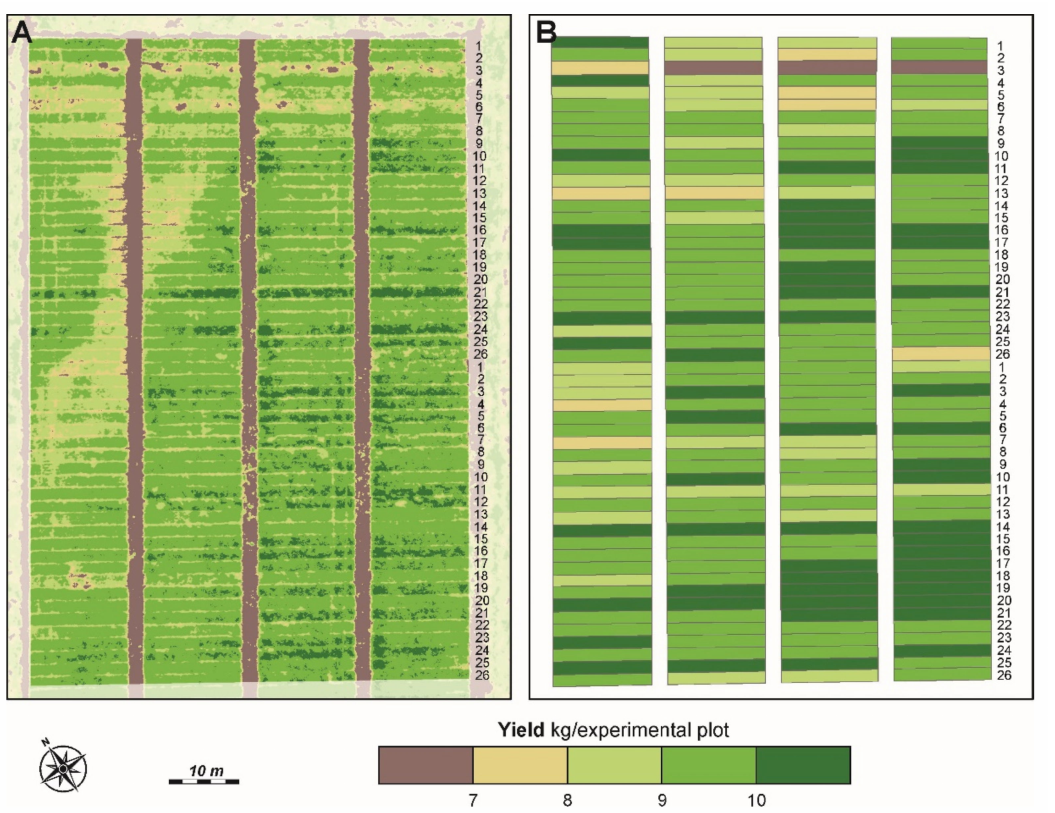
Figure 9. ( A ) UAV-obtained map of the estimated GY. The GY was estimated with the parametric model 3BSI-Tian/linear from grain filling phenological development stage. ( B ) Vector map of GY measured by mechanical harvesting at full maturity of the